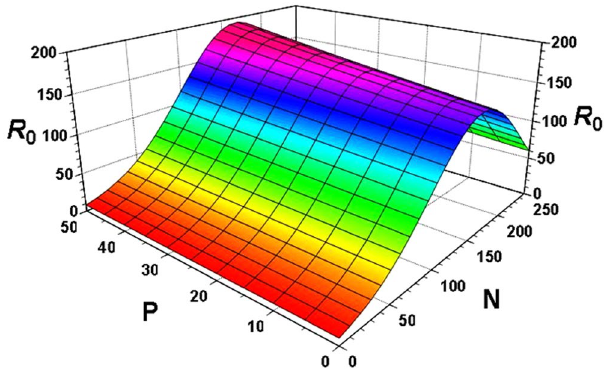
Figure 3. Effect of N and P on the reproduction rate ( R 0 ) of brown planthopper